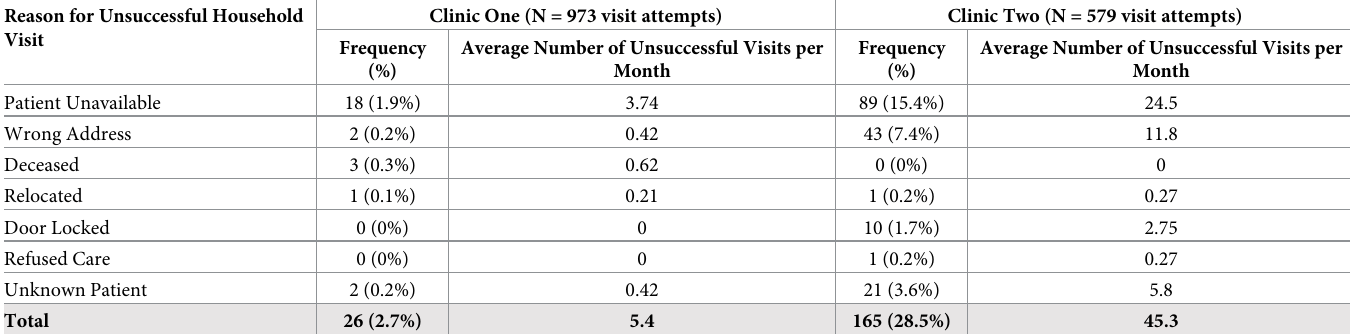
Table 4. Frequency of unsuccessful